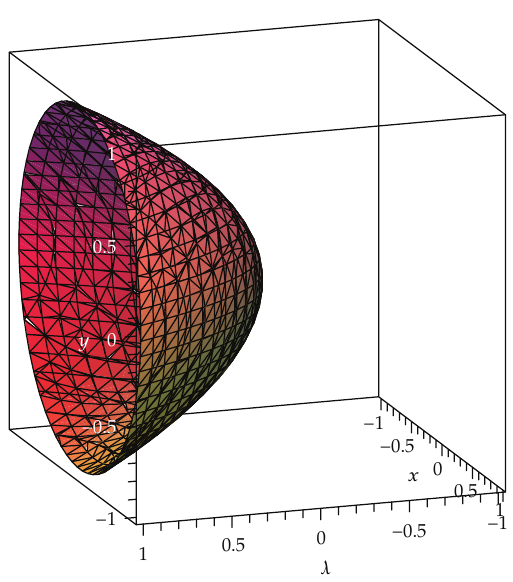
Figure 1: Bifurcation diagram of the equation λ − x 2 − y 2 (cid:4) 0 in Example